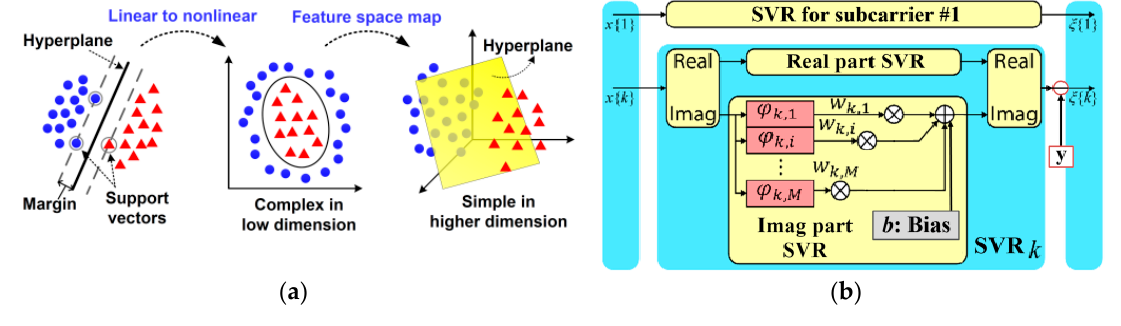
Figure 5. ( a ) CO ‐ OFDM receiver including NLE. ( b ) ANN ‐ NLE. MMSE: minimum ‐ mean square ‐ error